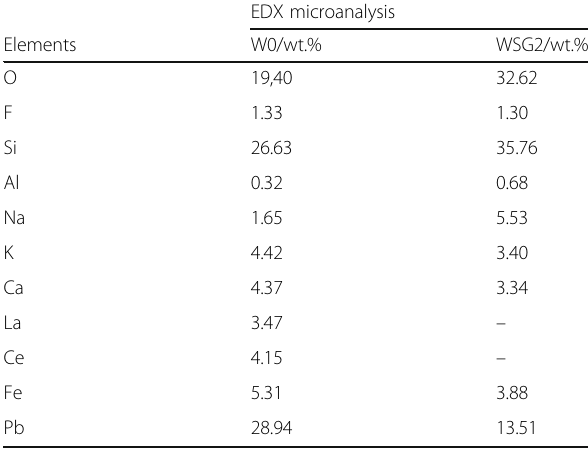
Table 4 EDX microanalysis of W0 and WSG2 samples sintered at 900 °C/2